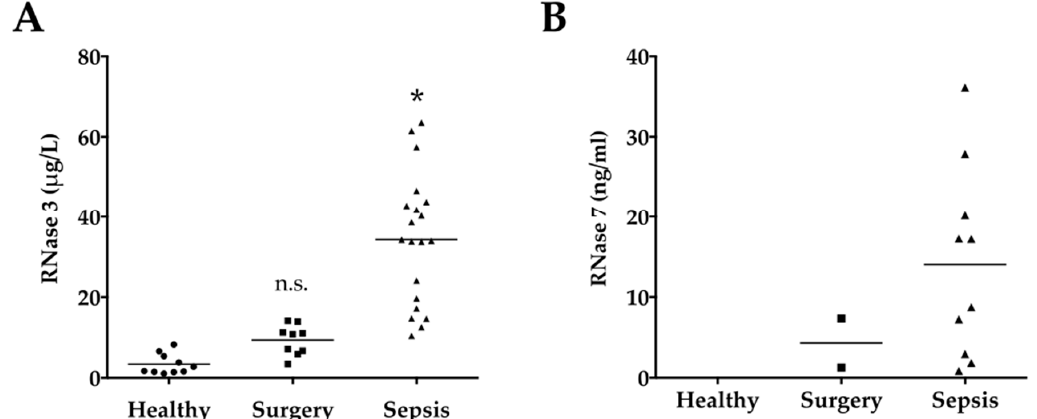
Figure 2. ( A ) RNase 3 serum levels. Serum levels of ribonuclease 3 (RNase 3) are displayed according to the groups; ( B ) RNase 7 serum levels. Serum levels of ribonuclease 7 (RNase 3) are displayed according to the groups. RNase 7 was not detected in Healthy, only in two patients of Surgery and in 10 of 20 sepsis patients. Black line indicates the mean. Groups: Healthy subjects ( n = 10), surgical ICU patients (Surgery, n = 9) and surgical ICU patients with sepsis ( n = 20) according to the definition published by the Surviving Sepsis Campaign [40]. * p < 0.05 vs. Healthy; n.s., non significant vs. Healthy.